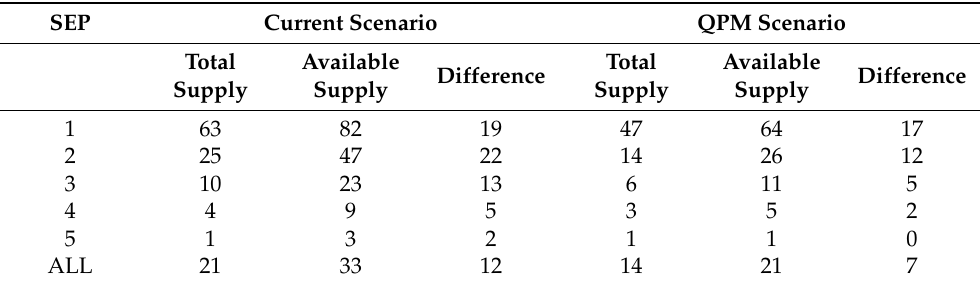
Table 5. The percentages of households at risk of lysine deficiency due to inadequate dietary supply including under a scenario with universal adoption of quality protein maize (QPM) stratified by socioeconomic position. SEP Current Scenario QPM